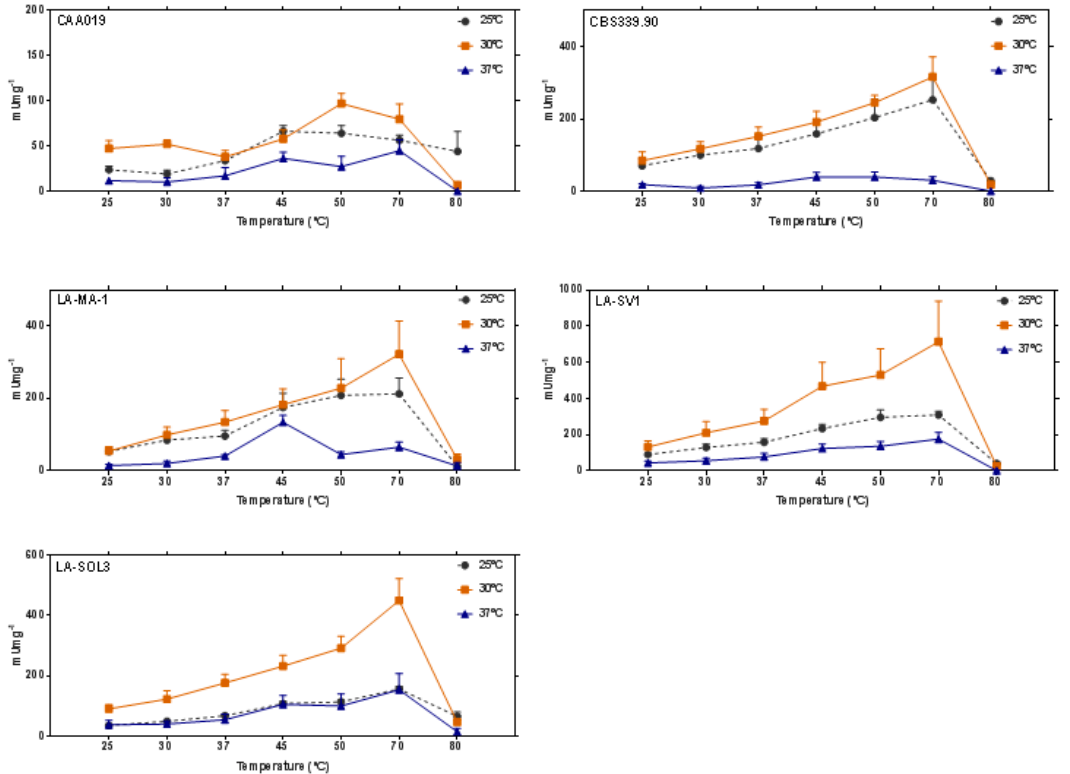
Figure 5. Extracellular endoglucanolytic activity of strains CAA019, CBS339.90, LA-MA-1, LA-SV1 and LA-SOL3 grown at 25 °C, 30 °C and 37 °C and assayed at 7 temperatures. Data is presented as average ± standard deviation.